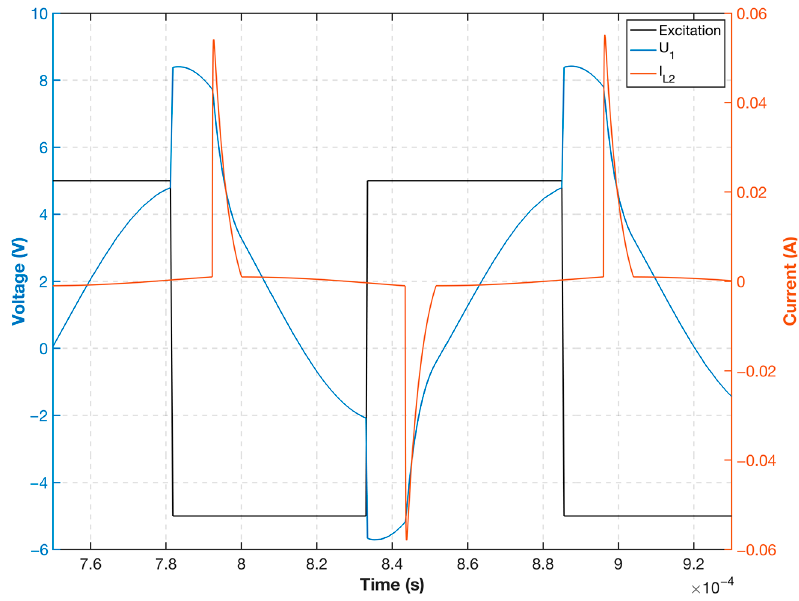
Figure 7. Excitation voltage and probe current mathematical calculation waveform.